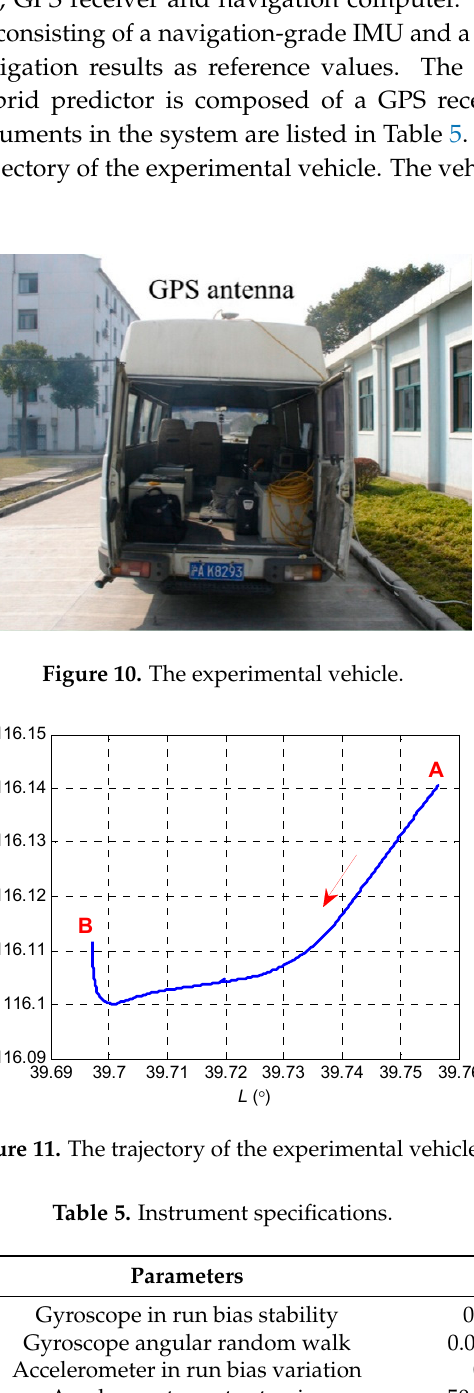
( b ) Figure 12. Navigation errors when there is a malfunction for a length of 120s: ( a ) Velocity errors; ( b ) Position errors. Figure 12 shows that, the velocity and position errors of the system with the first solution increase during the malfunction period. Specifically, the maximum errors of east and north velocity reach to 0.546 m/s and 0.399 m/s respectively. In addition, the maximum errors of latitude and longitude reach to 18.78 m and 39.23 m respectively. By contrast, the system with the PLSR-SVR hybrid predictor acquires better accuracy on both velocity and position. Since the predictor